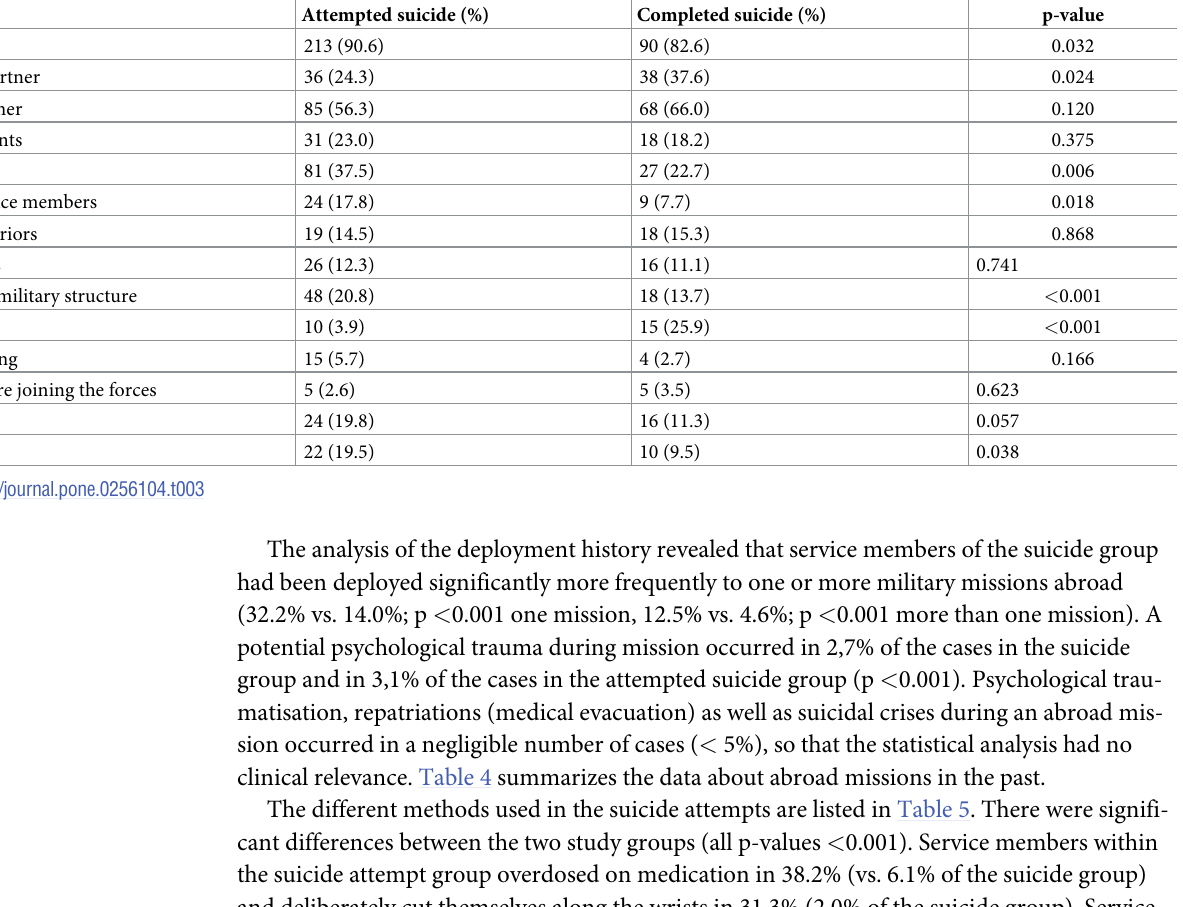
Table 3. Potential conflicts and stressors.